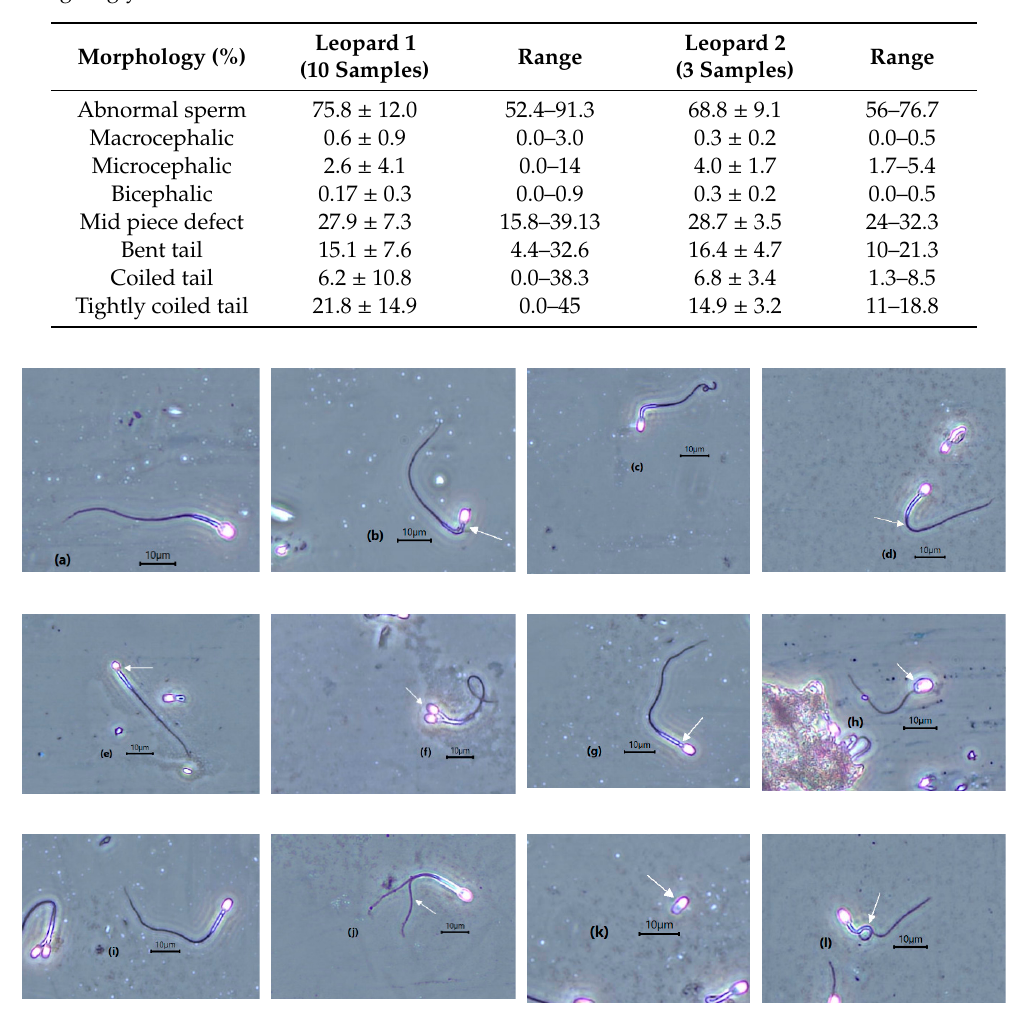
Table 4. Morphology of abnormal spermatozoa (average ± SD) of two Sunda clouded leopards living singly.